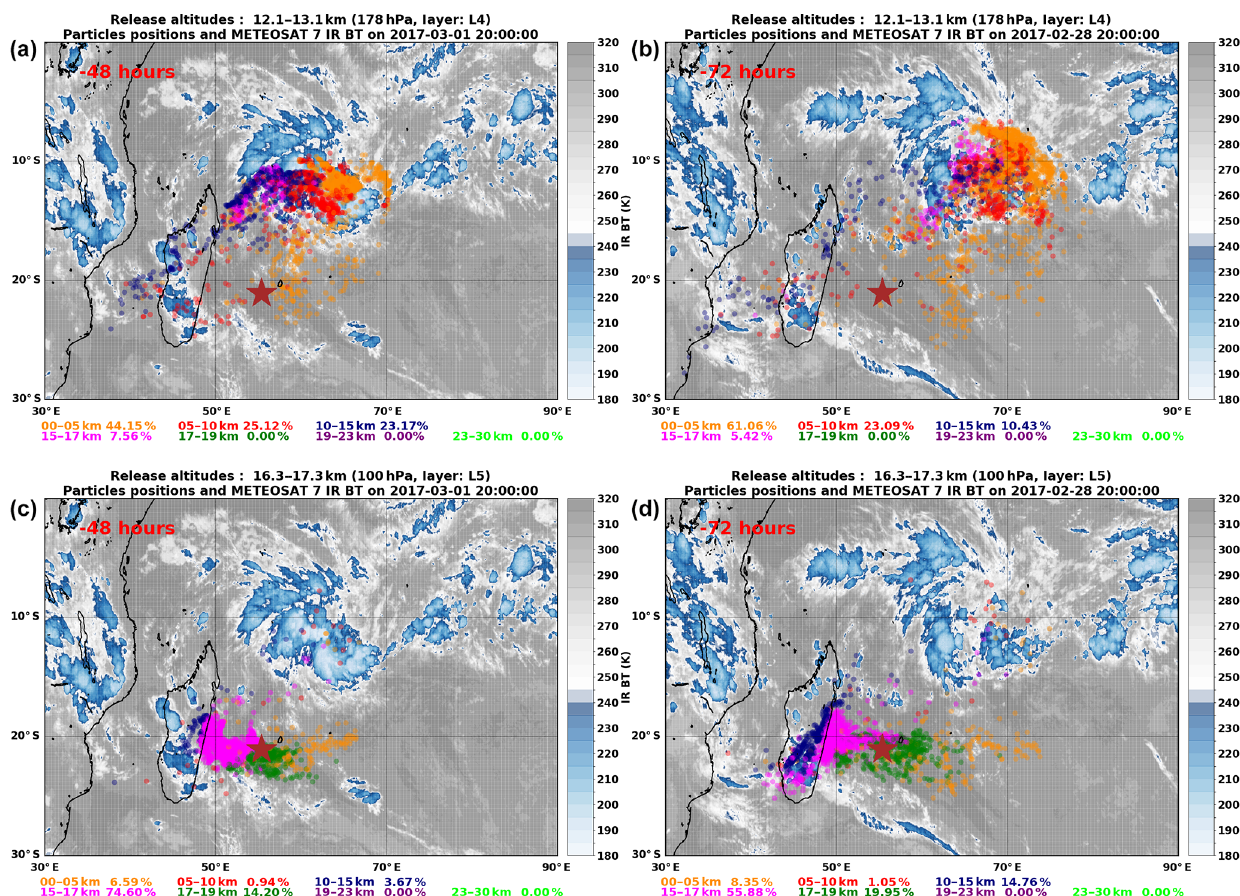
Figure 7. Backward trajectories calculated with the FLEXPART model for the CFH flight on 3 March 2017. In (a) and (b) , backward trajectories were initialized at 178hPa (layer L4) on 3 March 2017. The particle positions 2d before (on 1 March 2017 at 20:00UTC; b ) and 3d before (on 28 February 2017 at 20:00UTC; a ) are shown with respect to the Meteosat-7 cloud distribution at those times. The altitude range of the particles (e.g., 0–5km) and the percent of particles in that altitude range are indicated according to a color code shown in the bottom of each panel. (c, d) Same as (a) and (b) but for backward trajectories initialized at 100hPa (layer L5) on 3 March